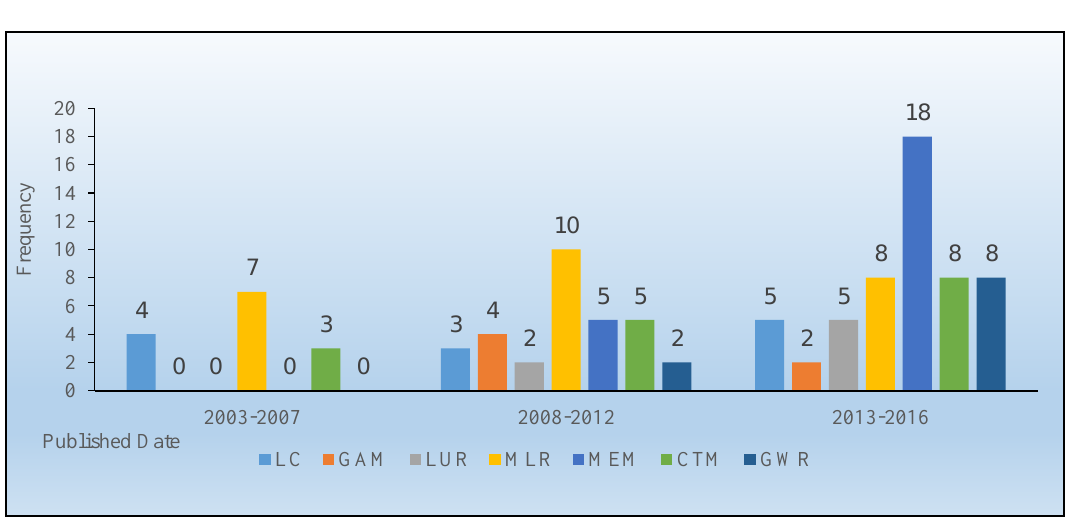
Figure 2. The frequency distribution of seven models.